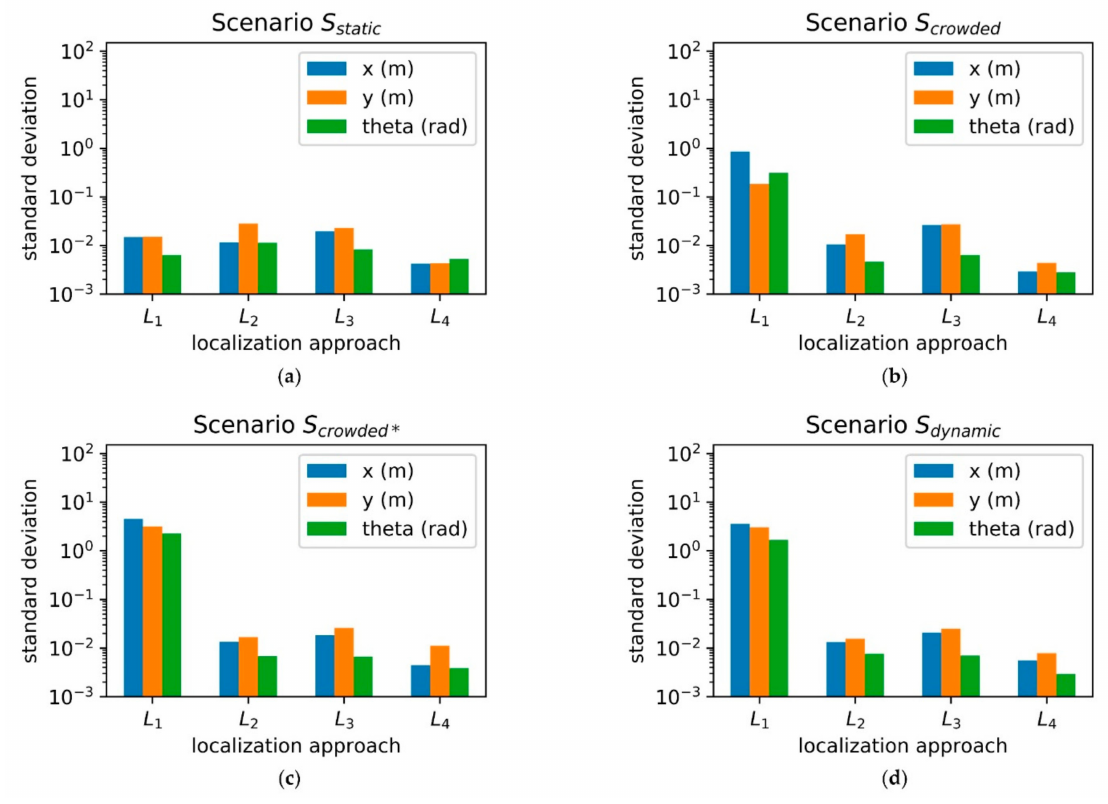
Figure 19. Localization experiment results. ( a ) S static ; ( b ) S crowded ; ( c ) S crowded ∗ ; ( d ) S dynamic . Table 3. Computational load and memory usage of the global localization